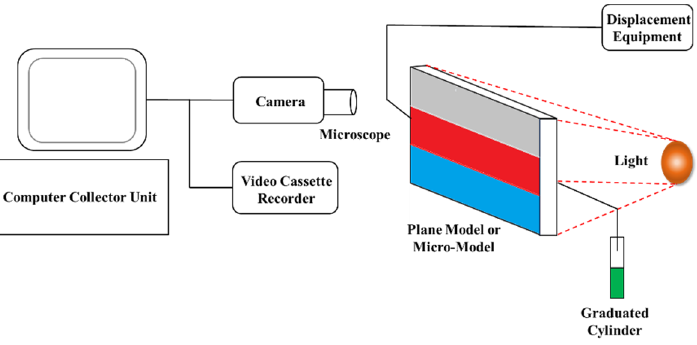
Figure 11. Schematic diagram of plane model and micro-model visual displacement